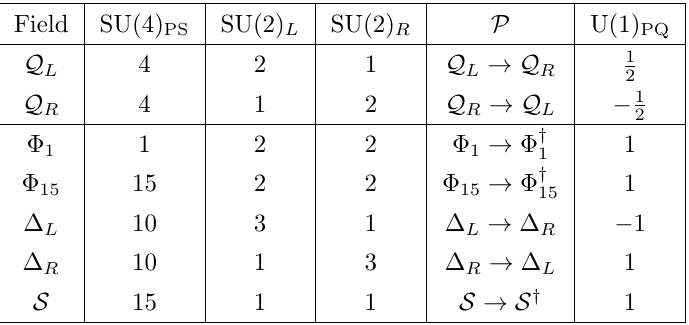
Table 1 . Field content of the minimal G PS (cid:2) U(1) PQ